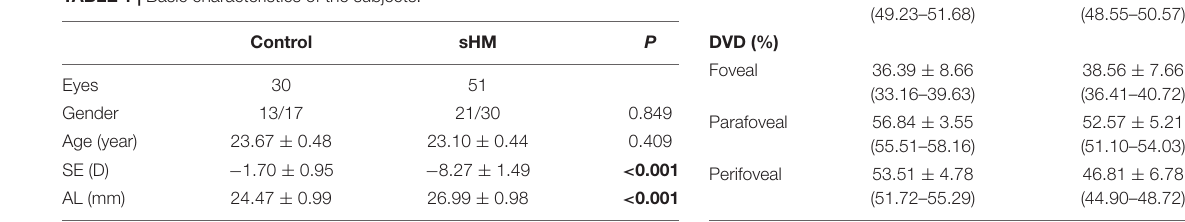
TABLE 1 | Basic characteristics of the subjects.